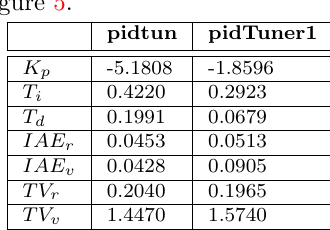
Table 2: Example 4.2. The table shows the PID con- troller ( m = 2) parameters, K p , T i , and, T d . It shows the performance, and input usage indices, IAE r , IAE v , TV r , and, TV v , corre- sponding to the reference and input distur- bance step time domain responses shown in Figure 5. pidtun pidTuner1 K p -5.1808